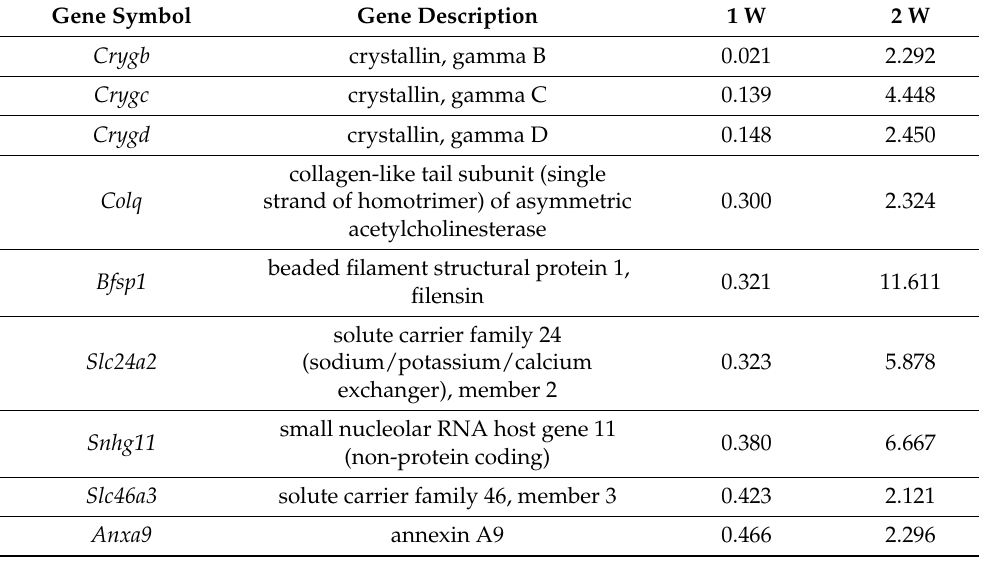
Table 3. Lists of genes which were < 0.5 times down-regulated at 1 W and > 2.0 times up-regulated at 2 W after extracapsular clear lens extraction (ECLE).